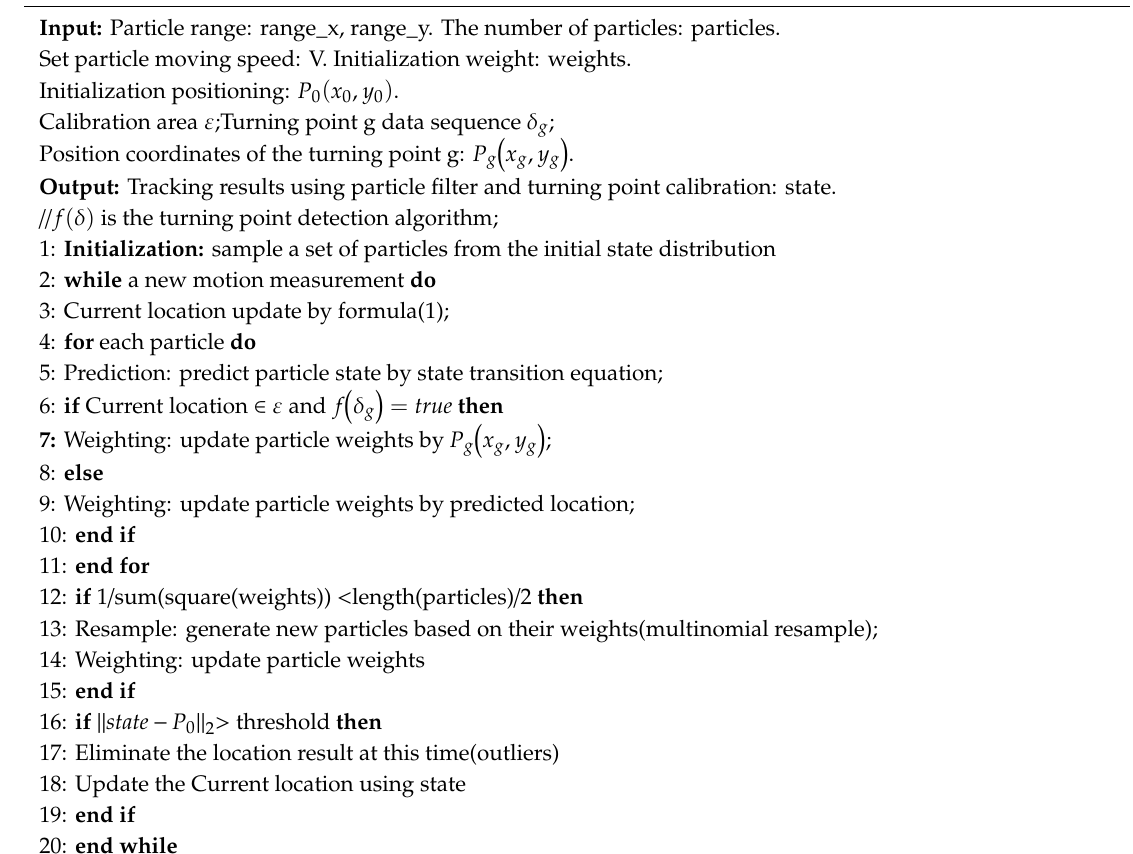
Algorithm 1: Fusion Process Based on Particle